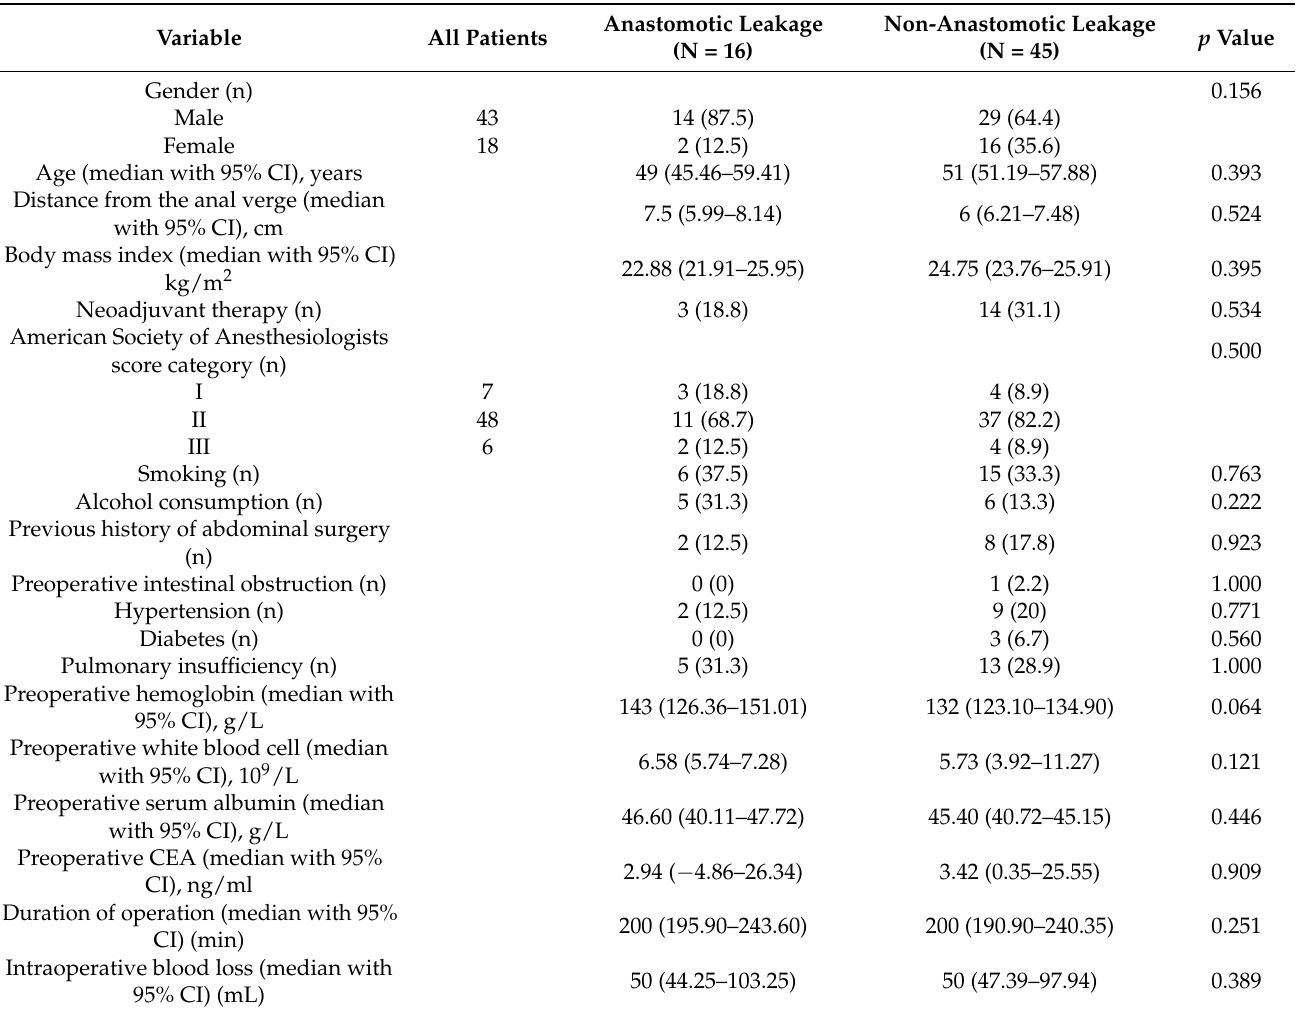
Table 4. Patients clinicopathological data after propensity score-matched